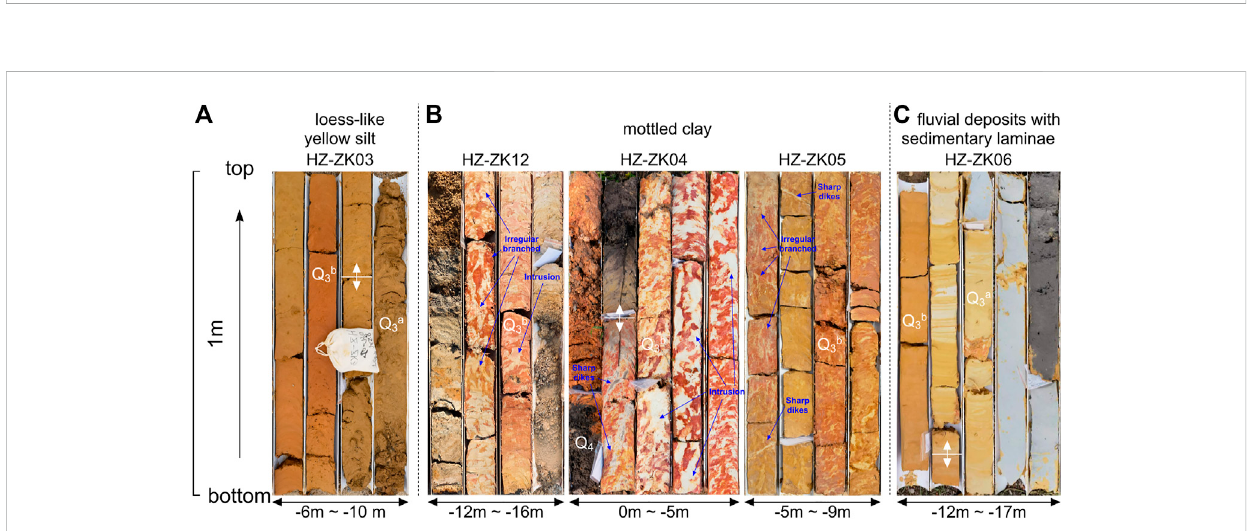
Comparison chart of the drilling cores in the Huizhou Basin. Cores HZK1-3 are according to Li et al. (2021). AMS 14 C and OSL dating results are also indicated.